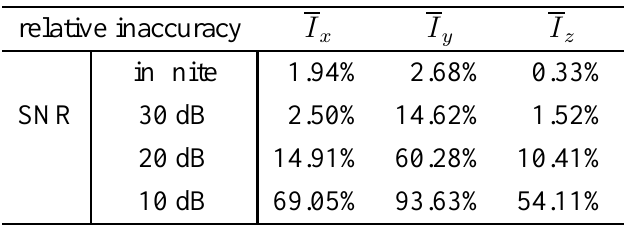
Table 2. The relations between the estimation error of sensor fusion system and the relative inaccuracy of the parameter